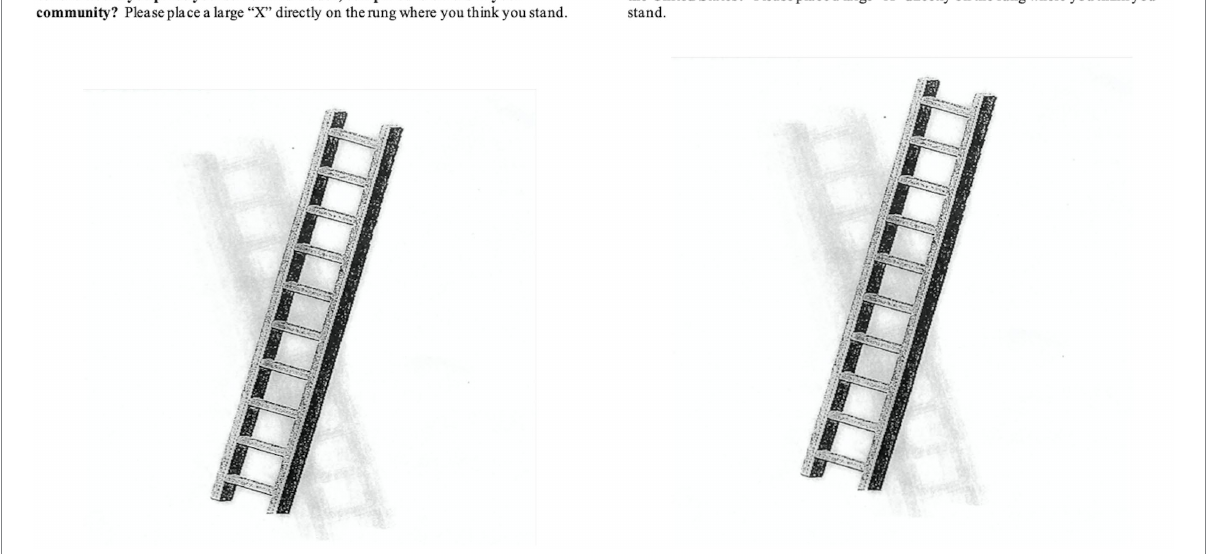
FIGURE 1 The two items of self-perceived SES used in this study. Items were adapted from the MacArthur scale of subjective social